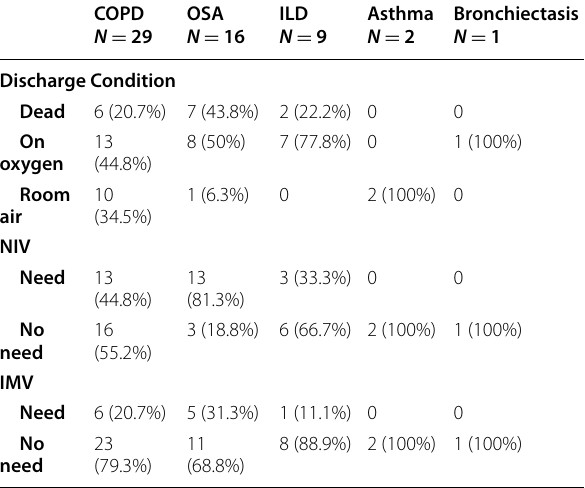
Table 1 Showing prognostic features of COVID-19 patients according to the type of comorbid chronic respiratory disease